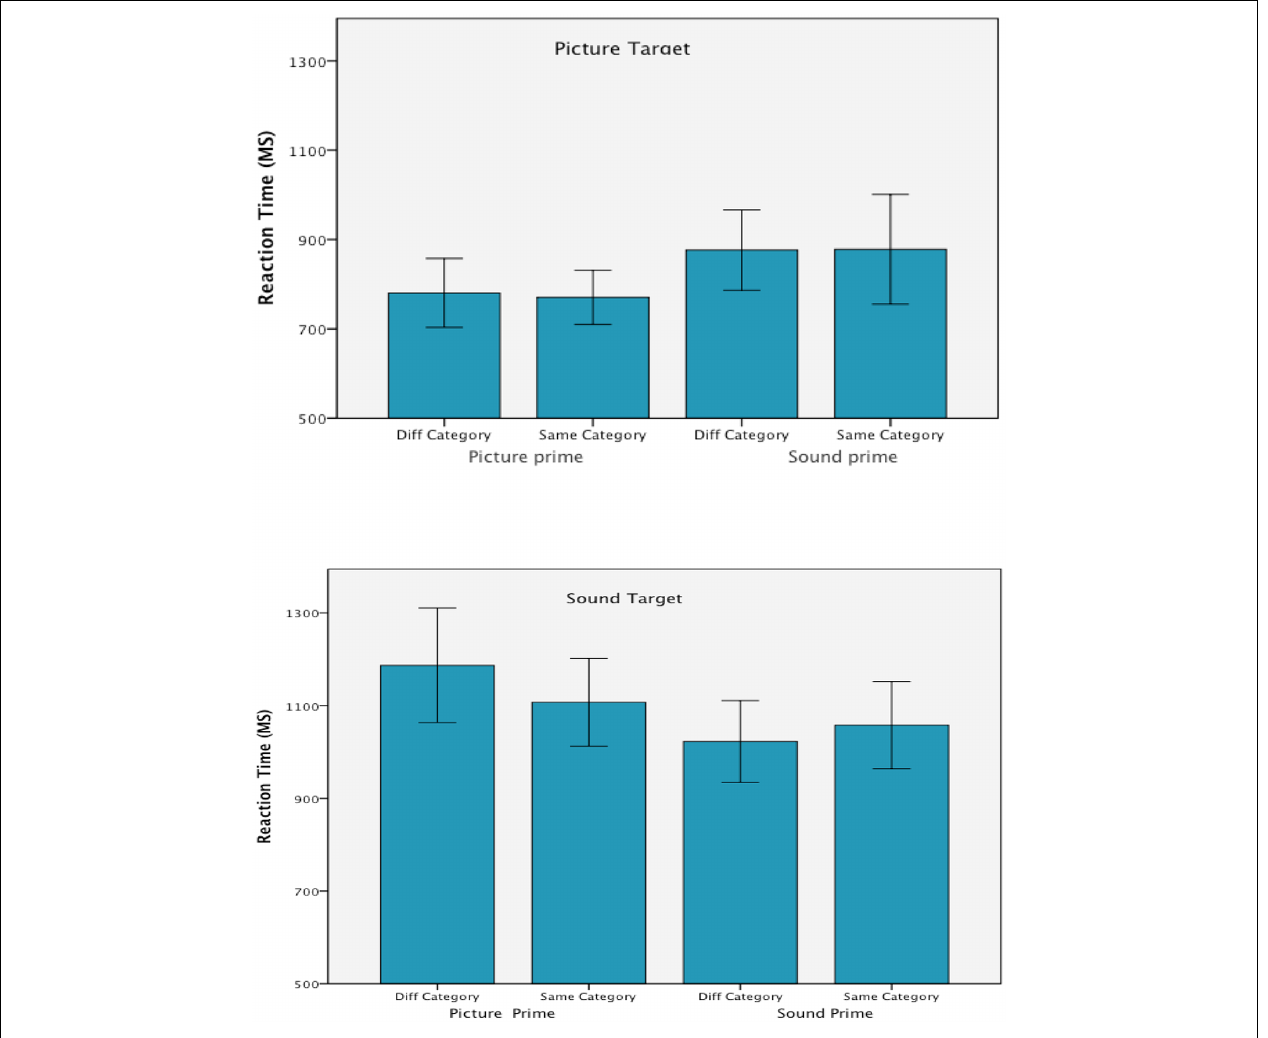
FIGURE 3 | Mean correct reaction time in each of the experimental conditions from Experiment 2. Error bars are 95% confidence